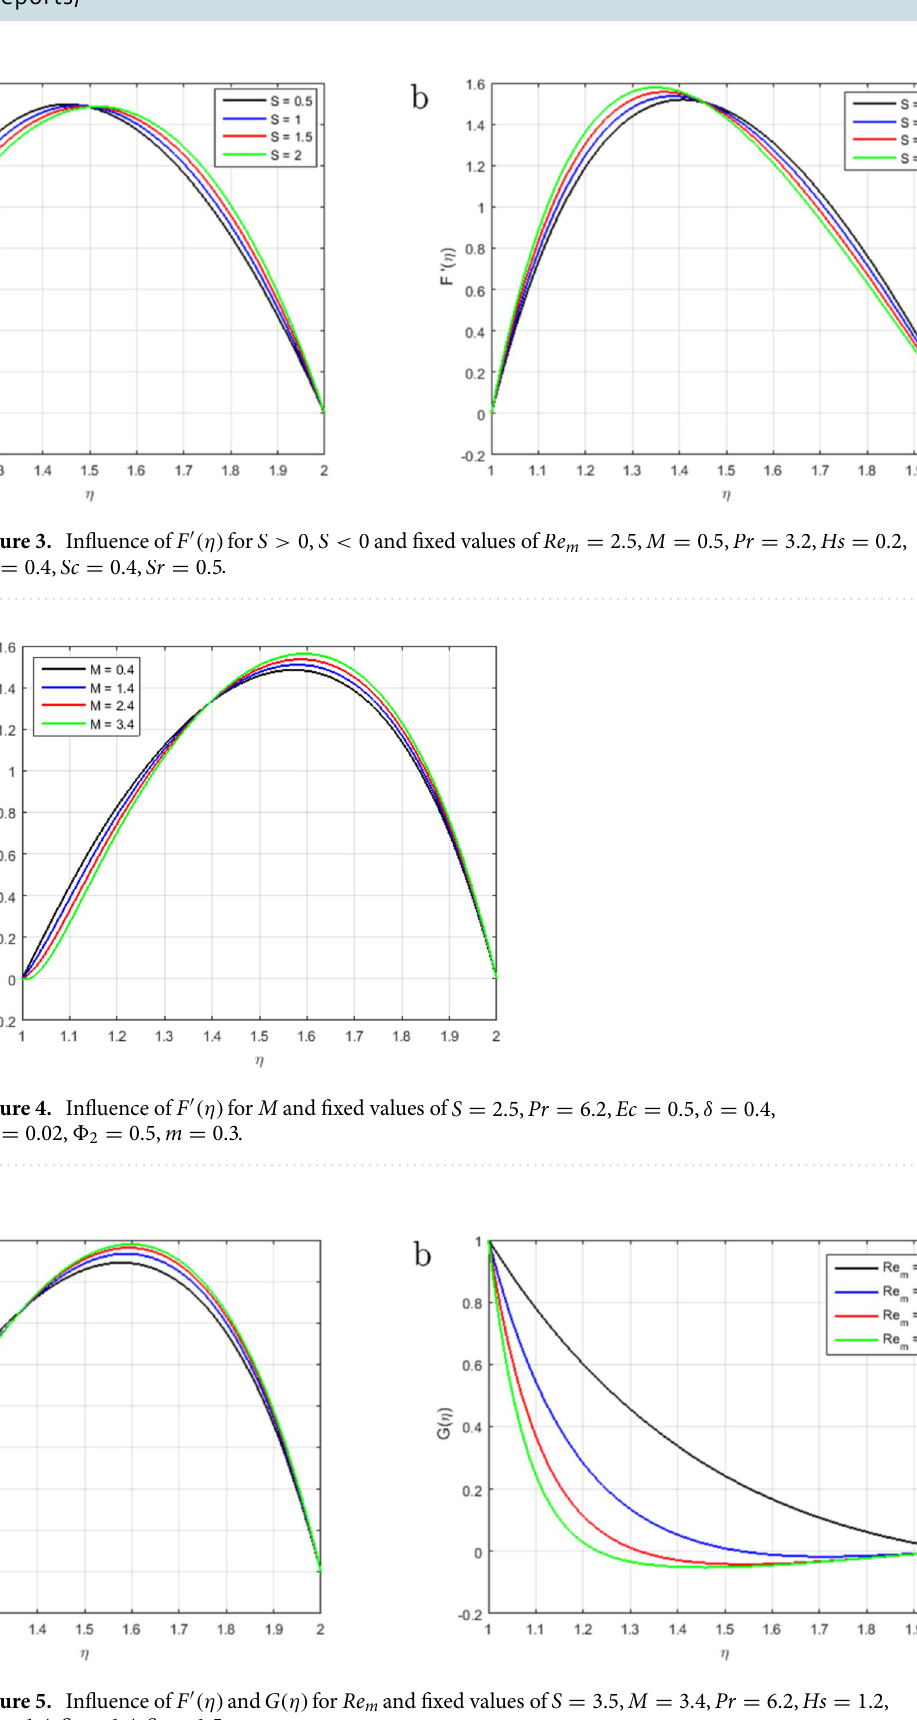
Figure 5. Influence of F ′ (η) and G (η) for Re m and fixed values of S = 3.5, M = 3.4, Pr = 6.2, Hs = 1.2, C 1 = 1.4, Sc = 1.4, Sr = 1.5